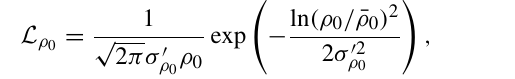
eachlikelihoodarethesameasthefunctionnamewithoutthelikelihood form, e.g. the capability for the ρ 0 likelihood is lnL_rh0